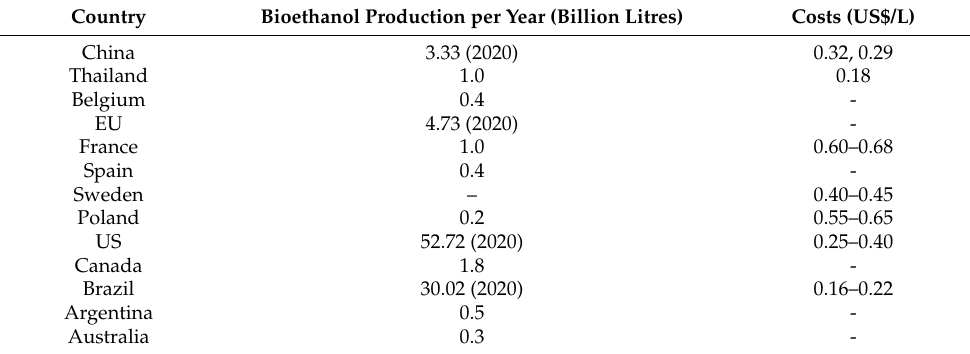
Table 4. Cost of bioethanol production in different countries/regions worldwide [71,72].